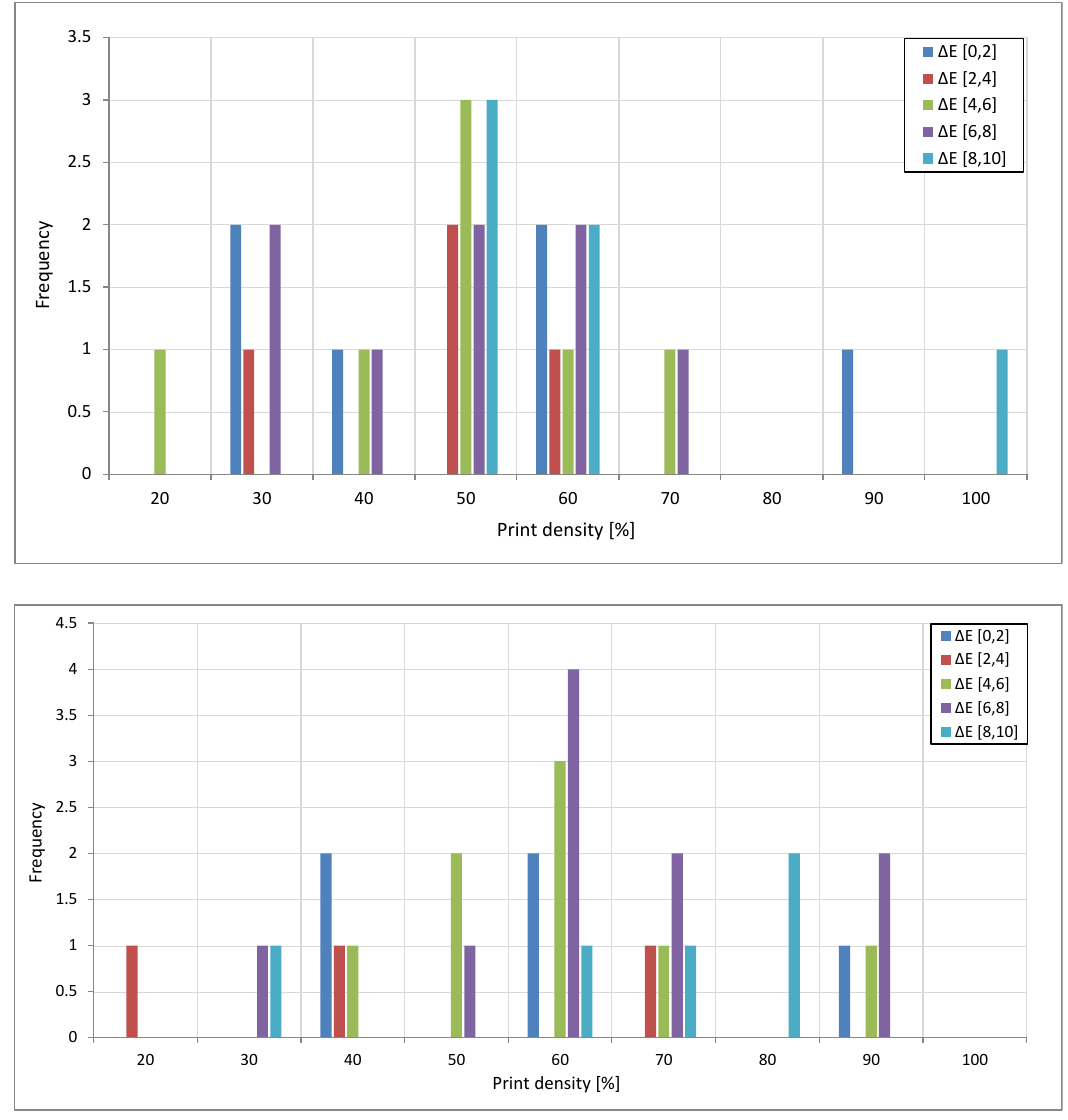
Figure A1. Histograms of computationally matched printed glass samples in Table 1 with ink volumes of 10 (top) and 20 (bottom) pl. Each histogram is itemised for print densities of 20–100% (no matches were found for 10%), and for ∆ E per print